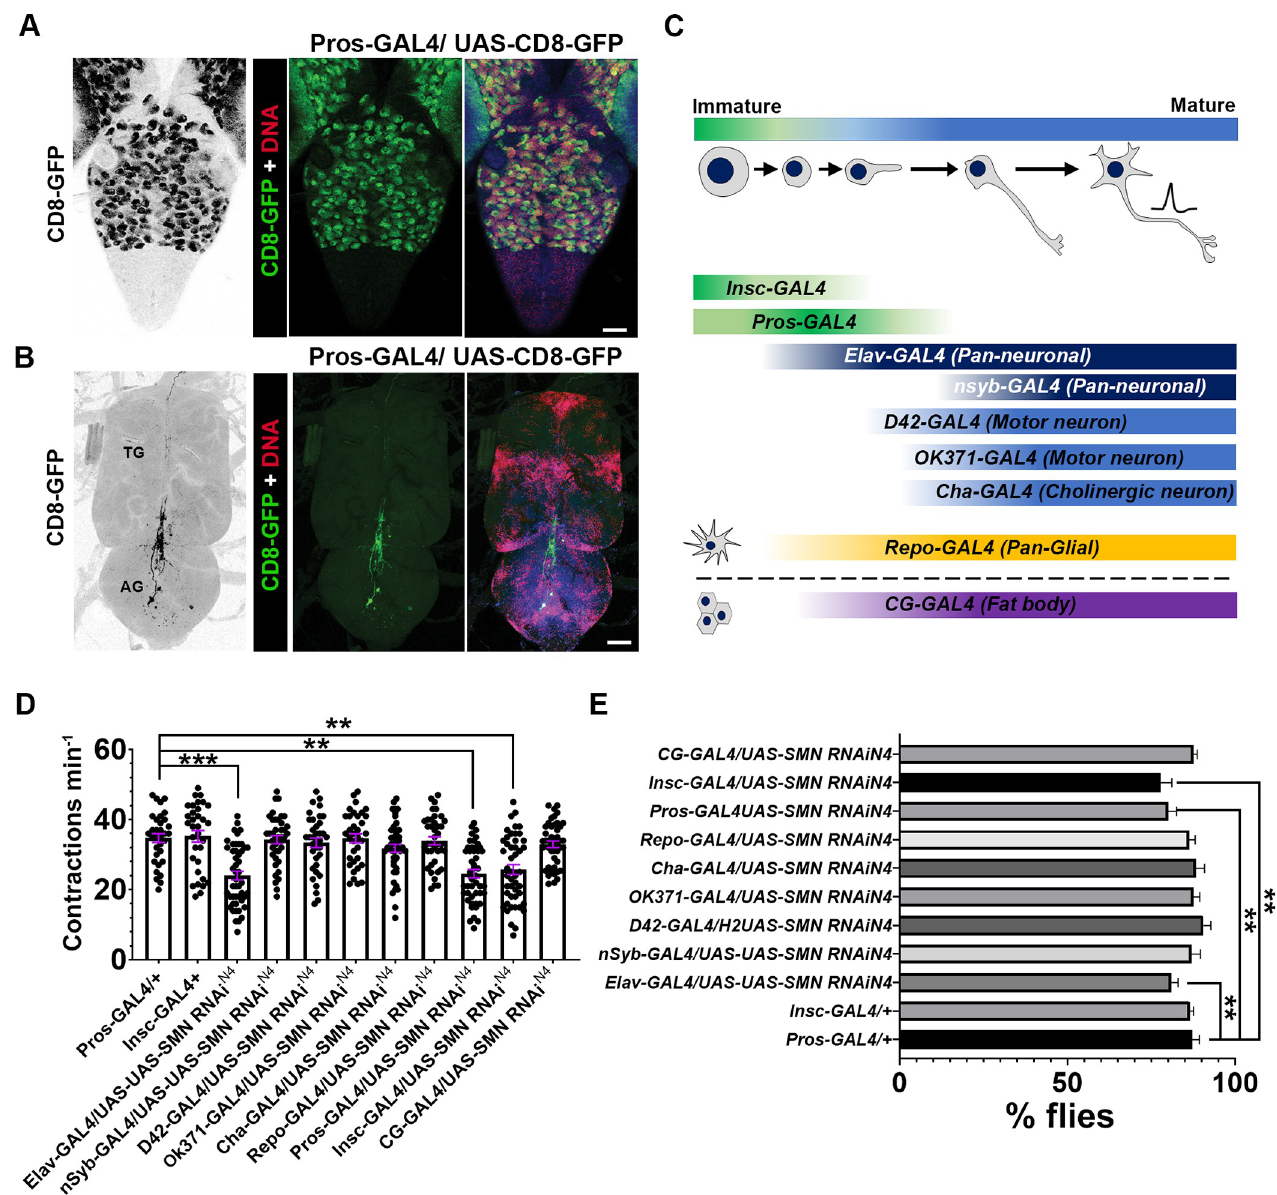
Fig 2. Survival motor neuron ( Smn ) knockdown in neurogenic cell types leads to larval developmental defects and locomotor dysfunction. (A) Pros-GAL4 driven expression of membrane-bound CD8-green fluorescent protein (GFP) in the larval central nervous system. GFP expression is observed in the post- embryonic neuroblasts and their immature daughter cells; (B) Pros-GAL4 expression in the adult ventral nerve cord. No neurons within the thoracic ganglion show visible expression. Only a small number of neurons, which reside in the abdominal ganglion within the ventral nerve cord of the adult, expressed Pros- GAL4 ; (C) GAL4 nervous system expression patterns detailing the neuronal and glial cell type expression patterns; (D–E) SMN was knocked-down ( UAS-SMN-RNAi N4 ) pan neuronally (Elav-GAL4 and nSyb-GAL4) predominantly in motor neurons ( D42-GAL4 and OK371-GAL4 ), cholinergic neurons ( Cha-GAL4 ), neuroblasts and undifferentiated daughter cells ( Pros-GAL4 and Insc-GAL4 ), pan-glia ( Repo-GAL4 ) and in the larval fat body ( CG-GAL4 ); (D) body wall contractions were scored at 48 h, with significant differences observed with Elav-GAL4 , Pros-GAL4 and Insc-GAL4 driven UAS-SMN-RNAi N4 ( �� P < 0.01, ��� P < 0.00, Kruskal–Wallis test with Dunn’s multiple Comparisons; n > 20); (E) day of pupariation formation (three experiments each with n > 50; Kruskal–Wallis test with Dunn’s multiple comparisons) data showing that Insc-GAL4 and Pros-GAL4 SMN knockdown leads to a delay in time to pupariation; All error bars [SEM]. Scale bar = 10 μ m.